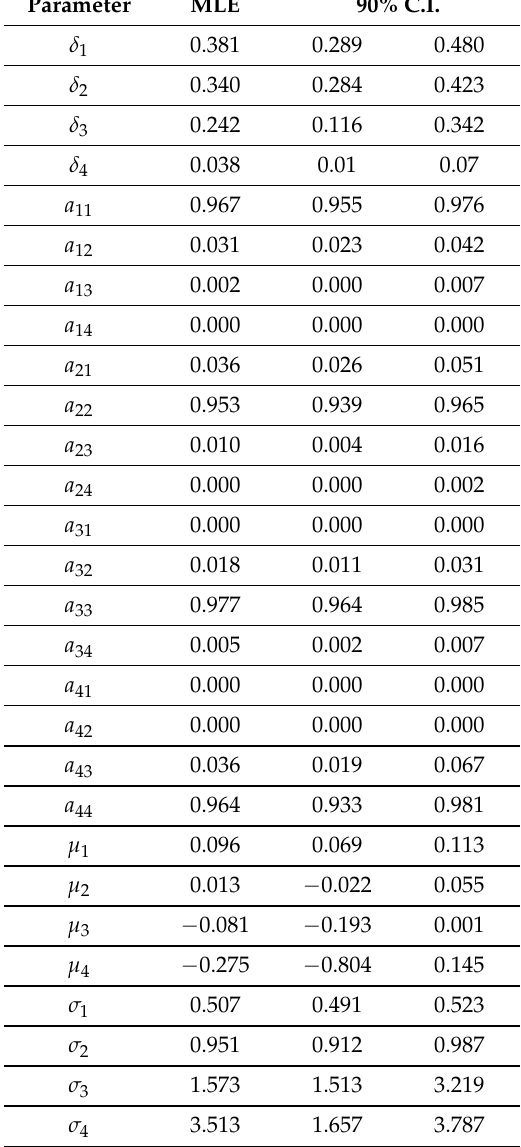
Table 5. Parameter estimates and parametric bootstrap confidence intervals for the stationary four-state HMM based on the complete S and P 500 log returns